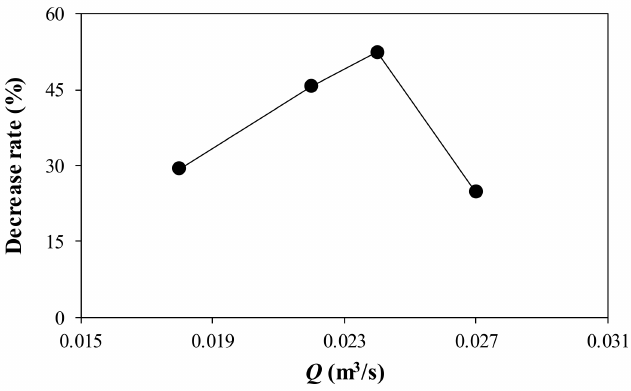
Figure 14. Mitigation of the surface vortex using the